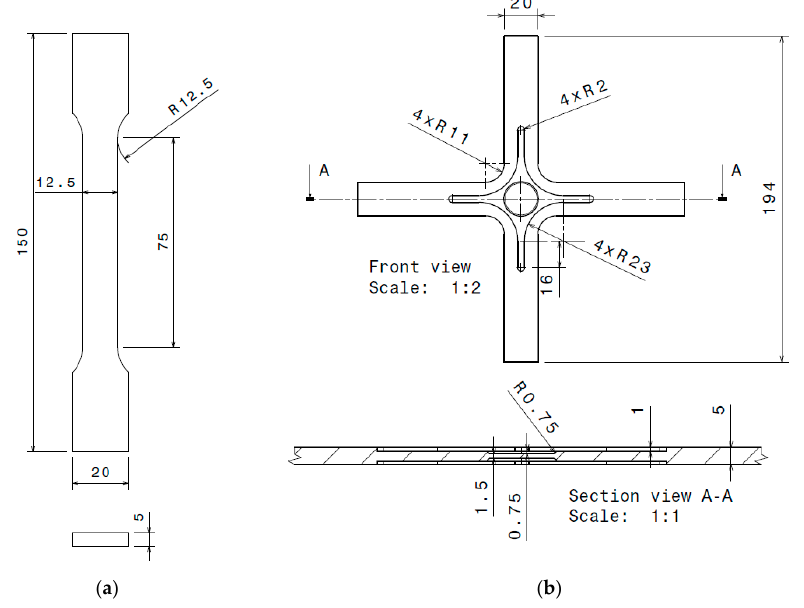
Figure 14. Specimens for tensile loading: ( a ) uniaxial; ( b ) biaxial.